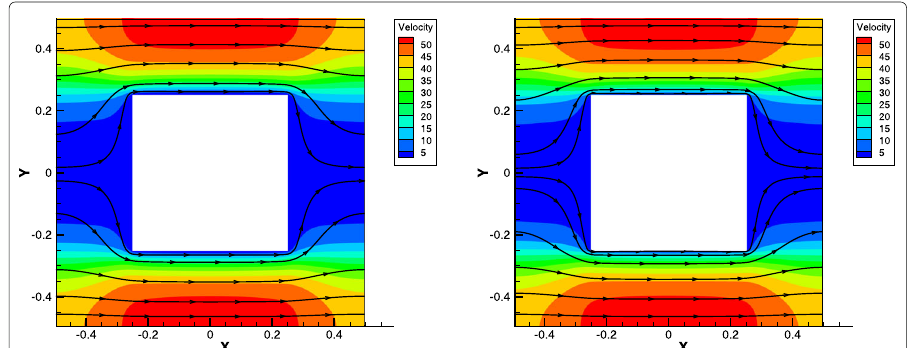
Fig. 8 The streamline and velocity magnitude of the micro flow through periodic square cylinders with Knudsen number Kn = 1.0 × 10 − 4 . Left figure shows UGKS solution and right figure shows the NS solution by GKS